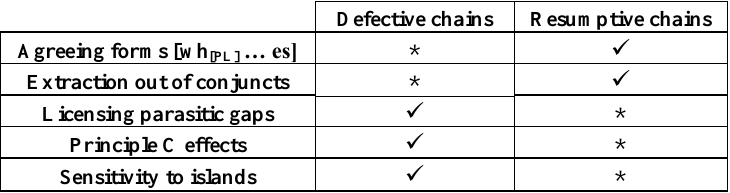
Table I. Defective versus resumptive